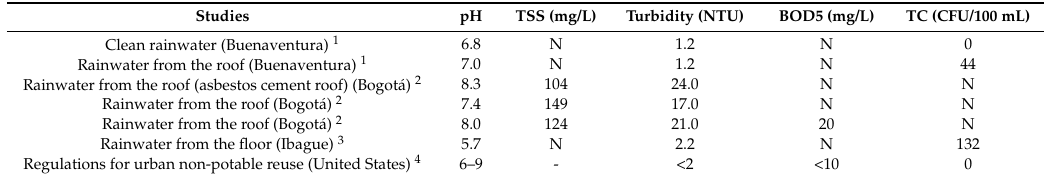
Table 1. Quality of harvested rainwater reported in several studies in Colombia and international regulations.